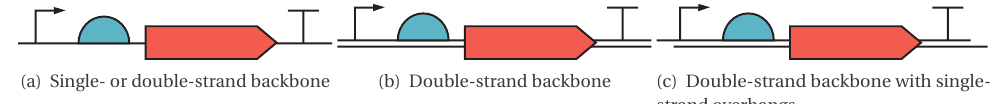
Figure 5: Example illustrating the elements of an SBOL Visual 2 diagram, with nucleic acid sequence features on the forward and reverse strand of a backbone, other molecular species, and interactions between elements; the grey labels and indicator lines are annotations.